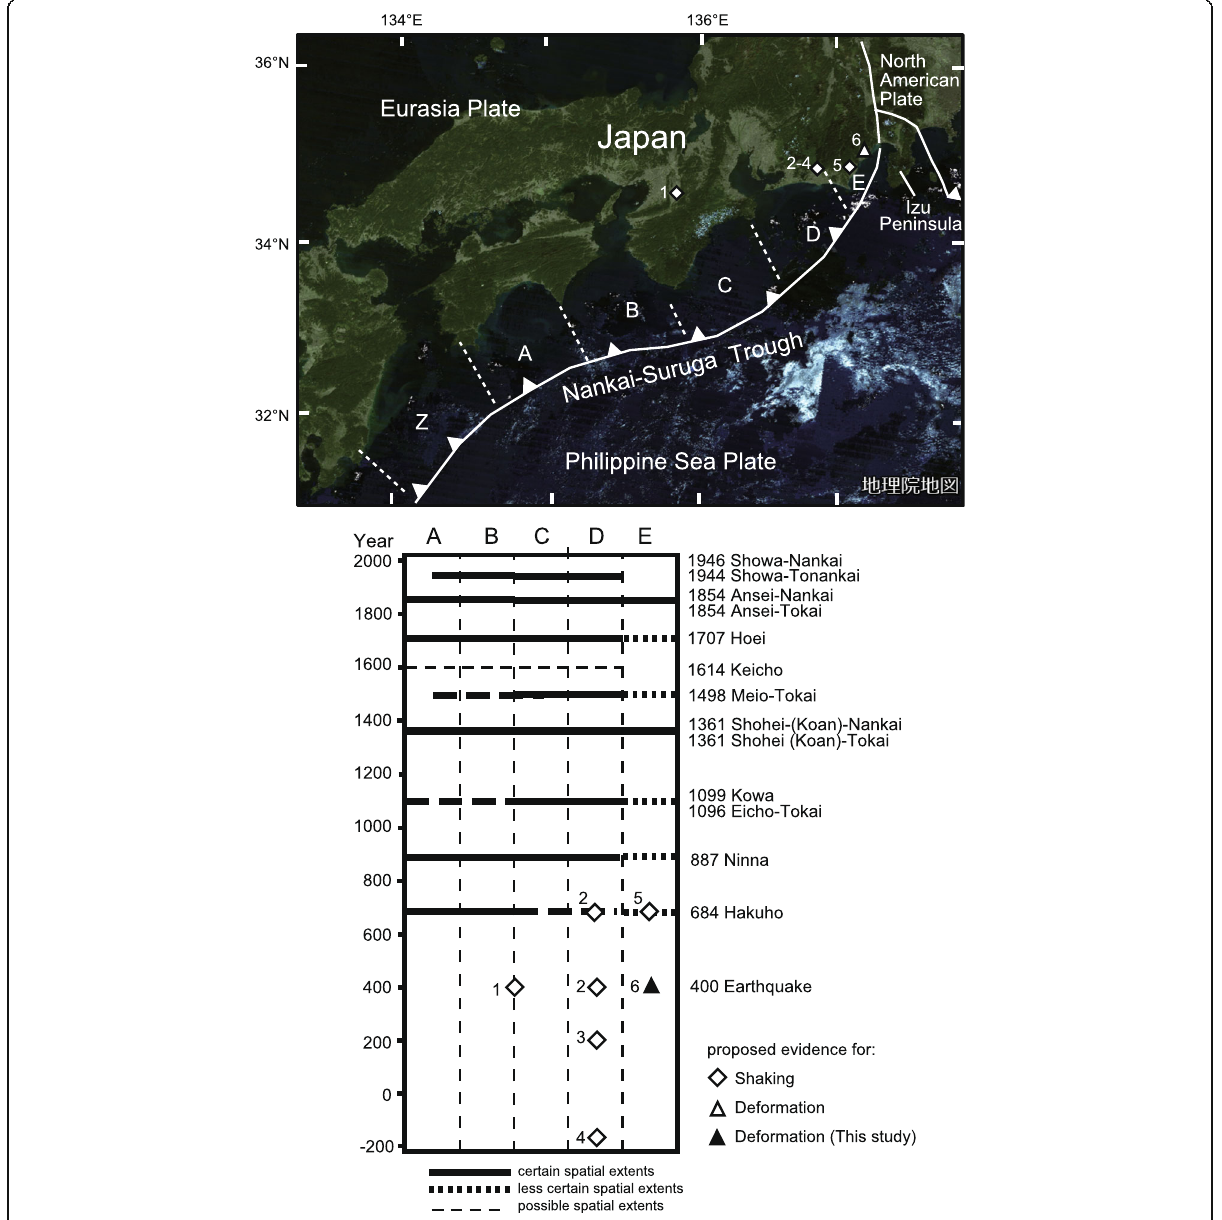
Fig. 1 Spatiotemporal distribution of great earthquakes along the Nankai and Suruga troughs, from Ando (1975b), Ishibashi and Satake (1998), Ishibashi (2014) and Kitamura et al. (2018a, b). Photographs are used with permission from the Geospatial Information Authority of Japan (https:// maps.gsi.go.jp/development/ichiran.html). 1 Akatsuchiyama mound tomb (data source: Sangawa (2013)); 2 Sakajiri (data source: Sangawa (2001)); 3 Tsurumatsu (data source: Sangawa (2001)); 4 Harakawa (data source: Sangawa (2001)); 5 Kawai (data source: Sangawa (2001)); 6 this